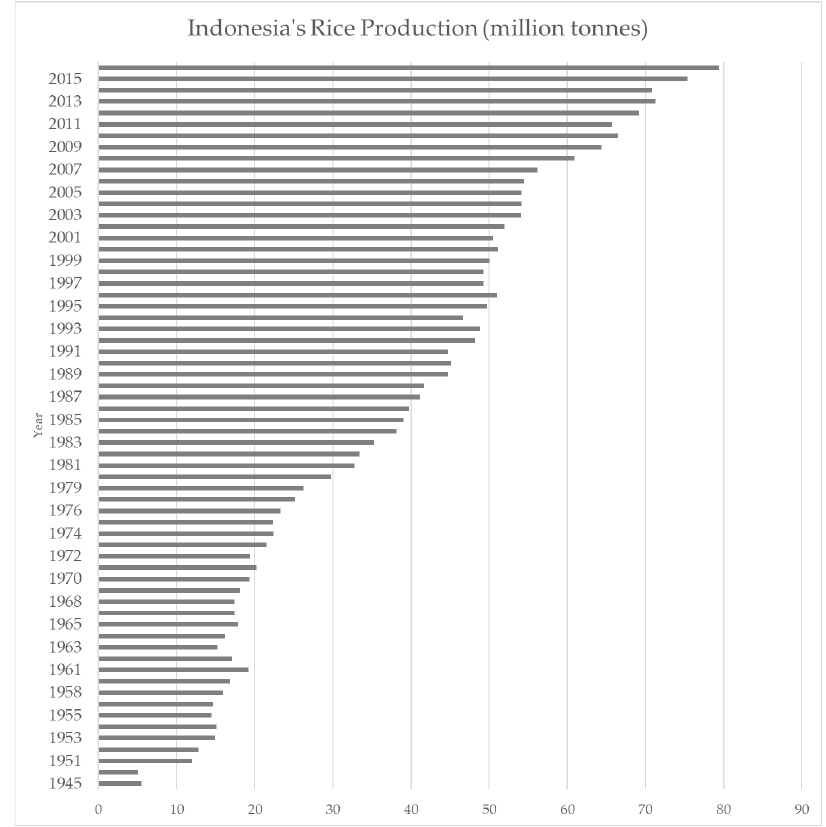
Figure 1. The Indonesian rice production from 1945 to 2016.